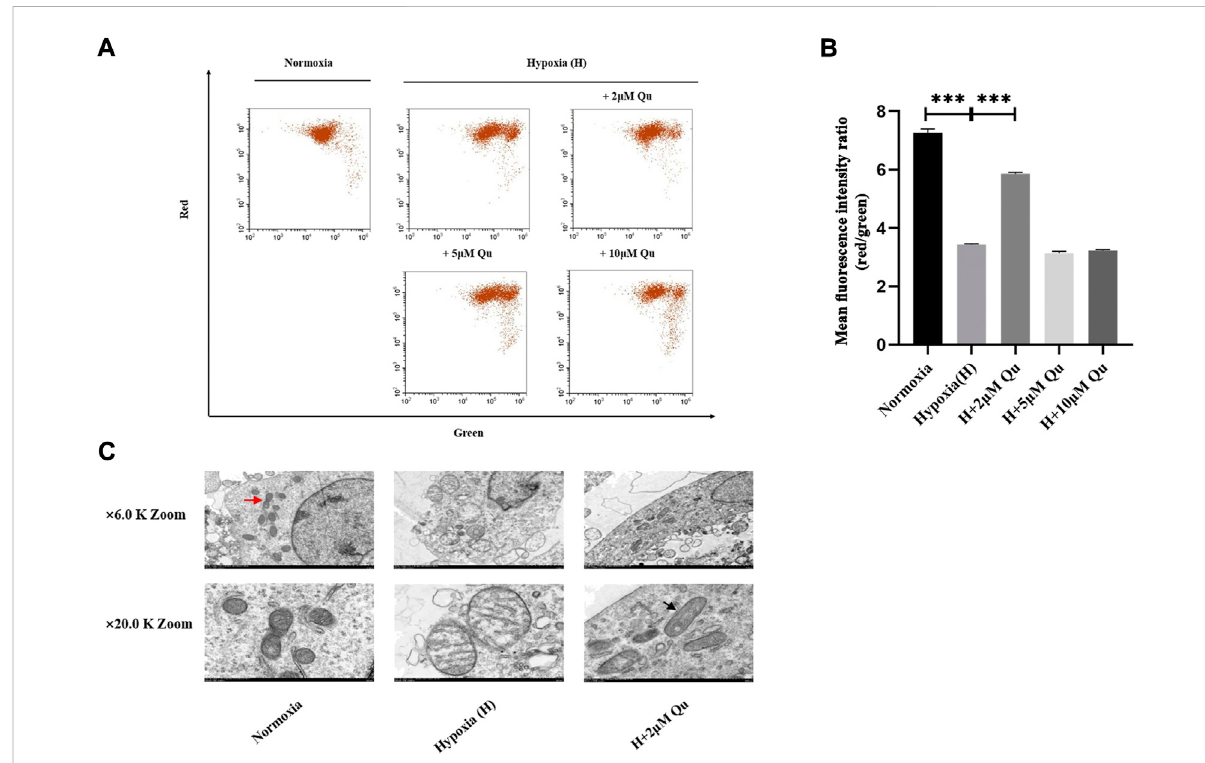
FIGURE 6 Quercetin improved mitochondrial membrane potential and mitochondrial morphology of trophoblasts under hypoxia condition. (A) Flow chart of JC-1 fl uorescence intensity. (B) Quantitative analysis of JC-1 aggregates (red fl uorescence)/monomers (green fl uorescence). (C) Representative TEM images of mitochondria in HTR-8/Svneo cells. n = 3, *** p < 0.001. Abbreviation: TEM, transmission electron microscopy; H, hypoxia; Qu,